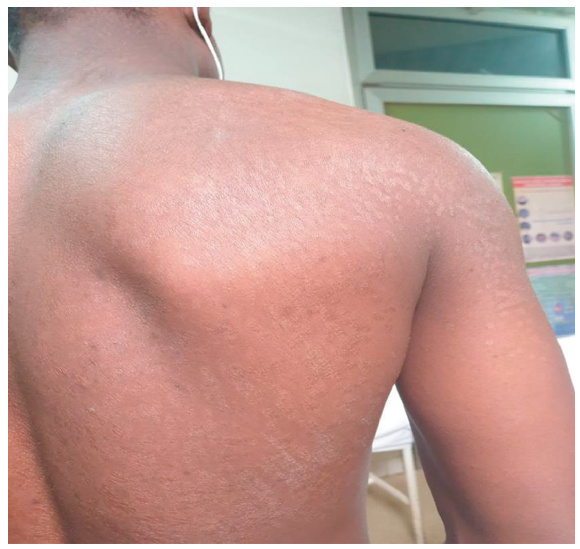
Figure 1: Scaly hypopigmented macular lesions of the trunk (months after the start of the second treatment).